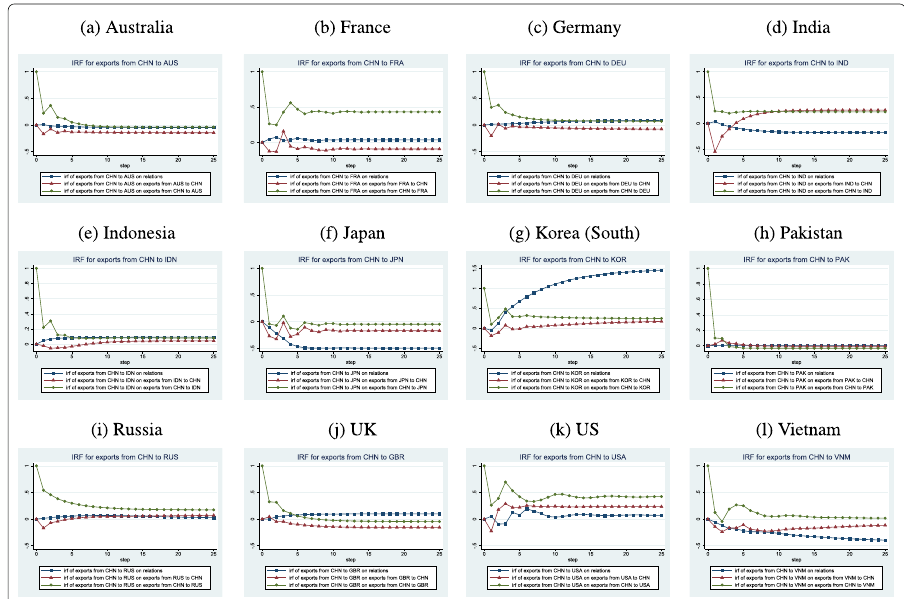
Fig. 4 IRFs for Exports from China to